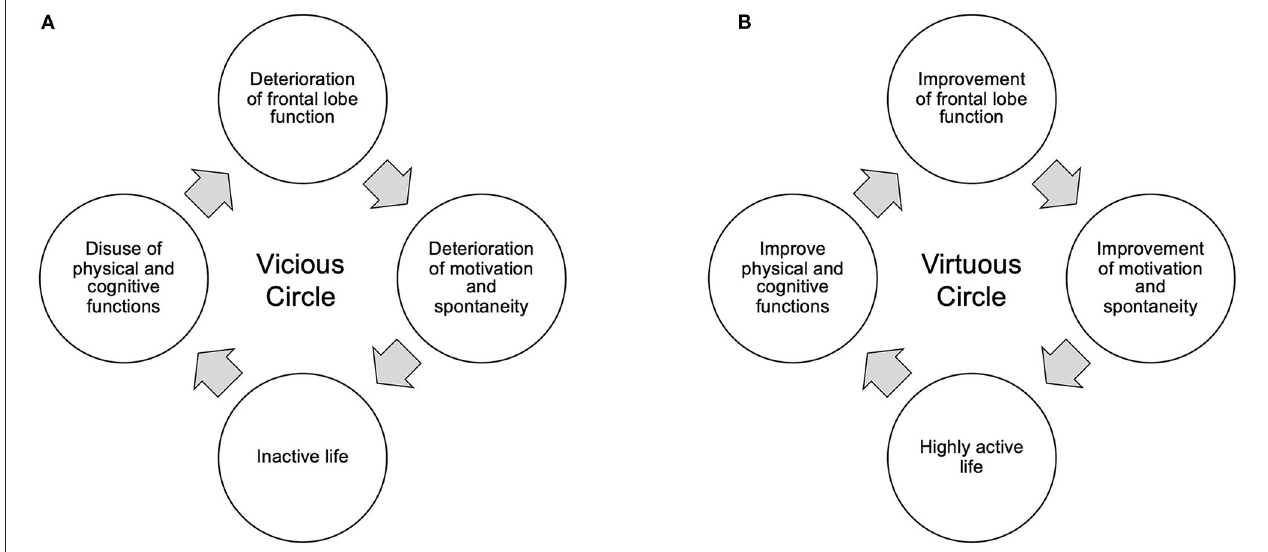
FIGURE 5 | Vicious (A) and virtuous (B) circles between frontal lobe function and activity of life. (A) Deterioration of the patient’s frontal lobe function reduces motivation, such as spontaneity, and leads the patient to a more inactive life. As a result, cognitive and physical functions decline due to disuse, leading to a vicious cycle of further decline in frontal lobe function. (B) Maintaining and improving frontal lobe function maintains and improves motivation, including spontaneity, and restores an active lifestyle. As a result, cognitive and physical functions enter a virtuous cycle of improvement.